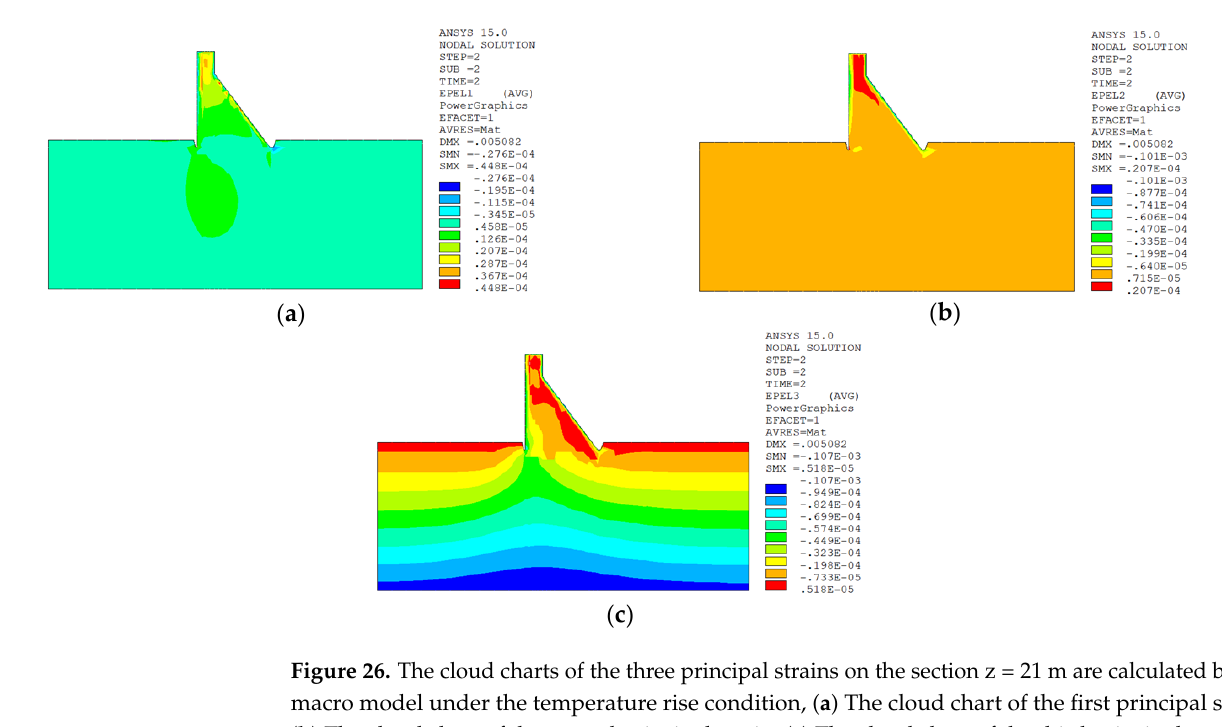
Figure 25. The temperature damage distribution of the dam is calculated by the macro model un- der the temperature rise condition, ( a ) Nephogram of temperature damage distribution of the dam, ( b ) Nephogram of temperature damage distribution of section z = 21 m. The three principal strain cloud charts on the section z = 21 m along the dam axis are shown in Figure 26.